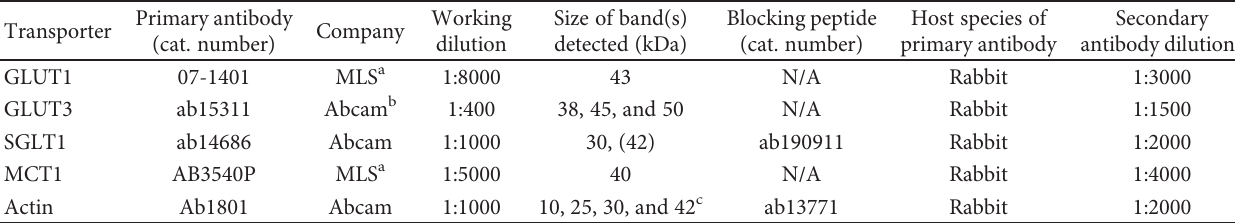
Table 2: Antibodies used for western blotting.